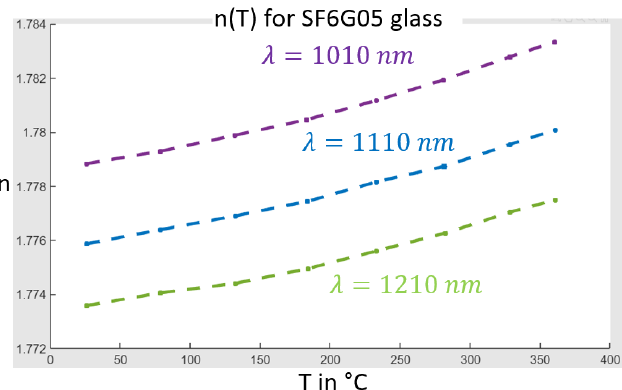
Figure 4 : n(T) obtained for SF6G05 glass using our setup and signal